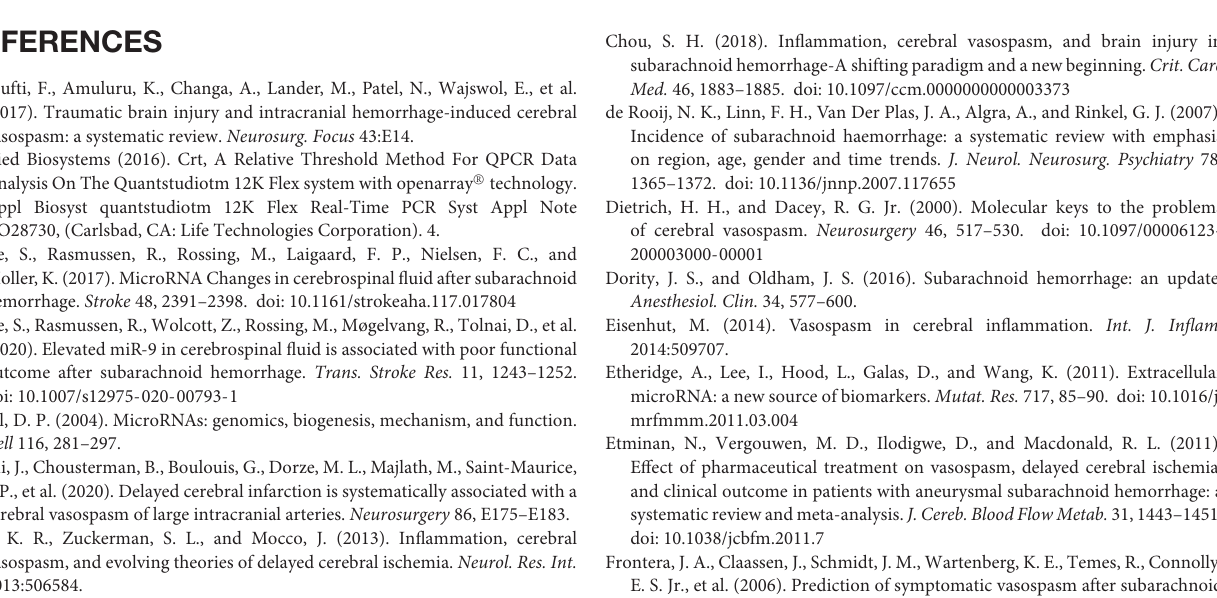
Supplementary Figure 1 | Workflow and estimated time needed for miRNA isolation and TaqMan TLDA analysis. Supplementary Figure 2 | Distribution of miRNA expression values for 26 miRNAs between DCV + and DCV- of the Group A cases. Each filled circle corresponds to a single case with “Yes” referring to DCV + and “No” referring to DCV-. Supplementary Figure 3 | ROC curves constructed using CSF miRNA data (PBD3) from aSAHs (DCV + plus DCV- group) and HCs. Supplementary File 1 | The file contains (1) variables without missing data; (2) DCV prediction cutoff value; (3) CSF dataset; (4) plasma